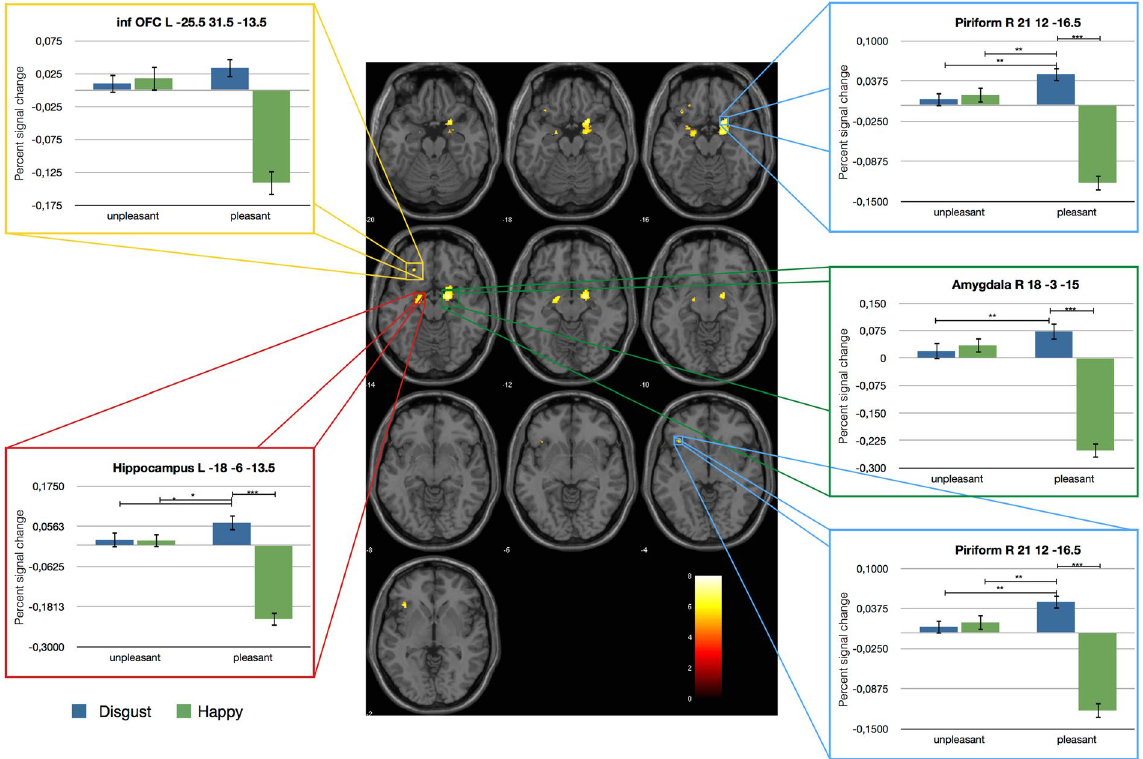
Figure 4. Activation pattern of the whole brain analysis for the olfactory network. The whole brain fMRI analysis revealed a consistent and specific activation pattern throughout the olfactory network and the triangular inferior frontal gyrus, showing that the emotionality of preceding facial expressions has only an impact on the processing of pleasant odors. Percent signal change for the main areas of activation is shown in the bar graphs: left inferior orbitofrontal Cortex (inf OFC L), left hippocampus, left triangular inferior frontal gyrus (tri inf frontal Gyrus L), right piriform Cortex (Piriform R) and right amygdala. *** Signifies a statistically significant difference at the threshold 0.001 corresponding to a FWE-Corrected threshold of 0.05.